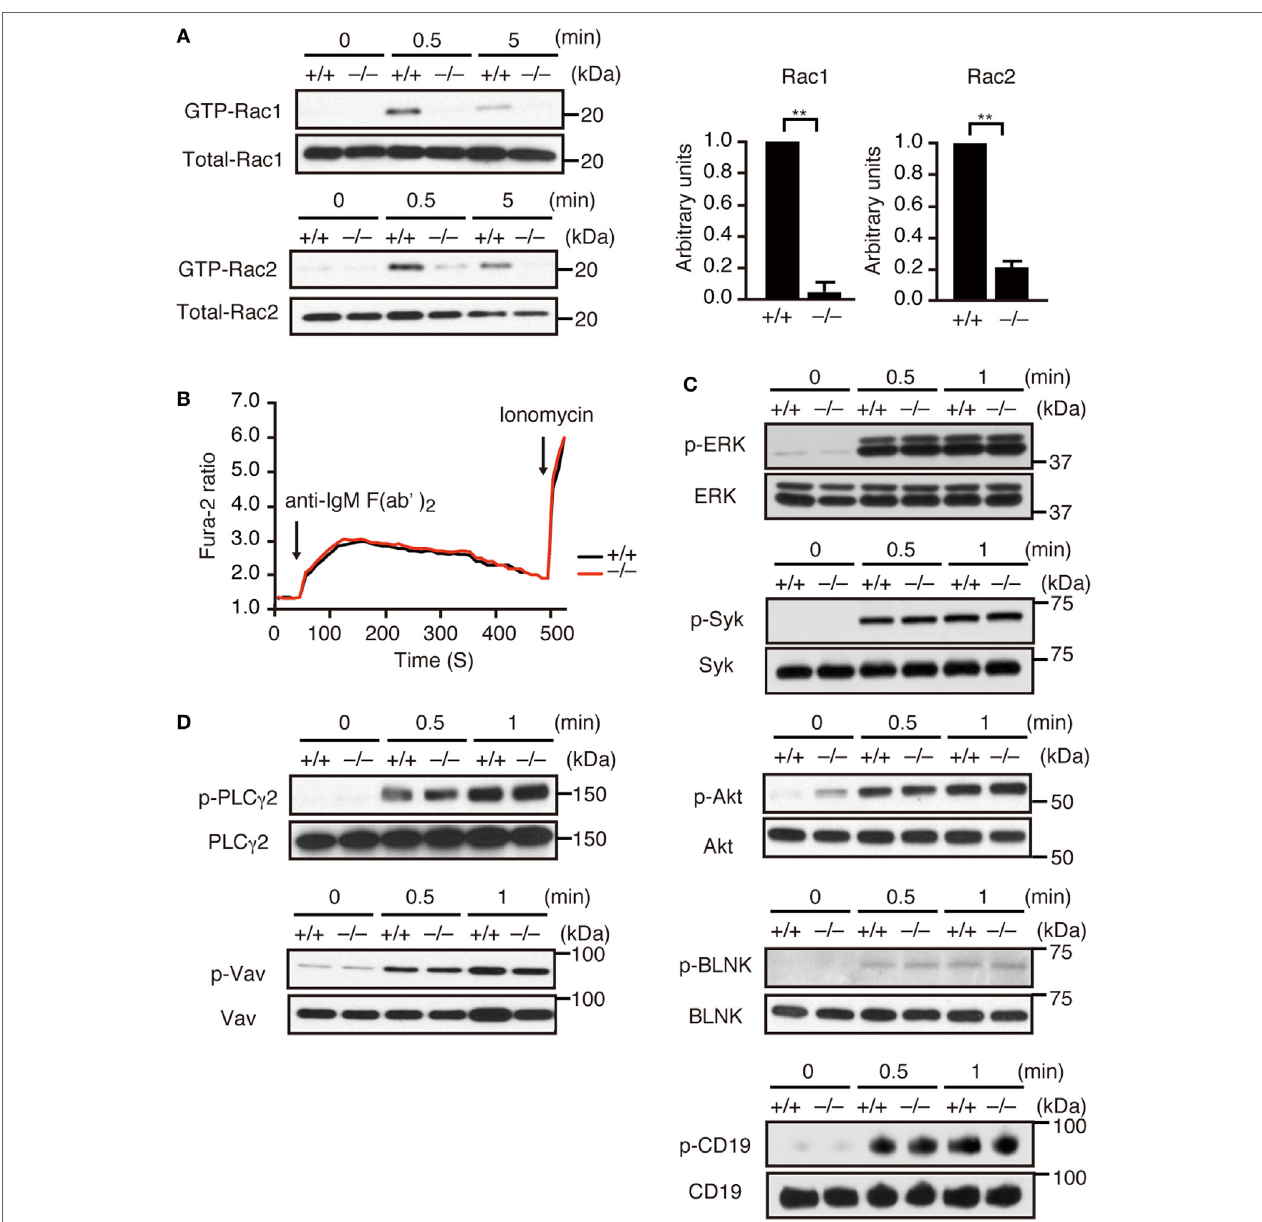
FigUre 1 | DOCK2 is a major Rac GEF acting downstream of B cell receptor (BCR). (a) BCR-mediated activation of Rac1 and Rac2 were compared between Dock2 + / + and Dock2 − / − lymph node (LN) B cells. Results were quantified by densitometry and are expressed as the ratio of GTP-bound form to the total protein after normalization of the 0.5 min-value of Dock2 + / + samples to an arbitrary value of 1. Data for 0.5 min are indicated as the mean ± SD of five independent experiments. ** p < 0.01 (two-tailed Mann–Whitney test). (B) Fura-2-loaded Dock2 + / + and Dock2 − / − LN B cells were stimulated with anti-IgM F(ab ′ ) 2 antibody or ionomycin. Data are indicated as the Fura-2 ratio at 340:380 nm and are representative of three independent experiments. (c,D) Dock2 + / + and Dock2 − / − LN B cells were stimulated with anti-IgM F(ab ′ ) 2 antibody and analyzed for phosphorylation of each molecule. In (c) , phosphorylations of ERK, Syk, Akt, BLNK, and CD19 were analyzed using phosphorylation-specific antibodies. In (D) , cell extracts were immunoprecipitated with anti-Vav or anti-PLC γ 2 antibody and analyzed with anti-phosphotyrosine antibody.